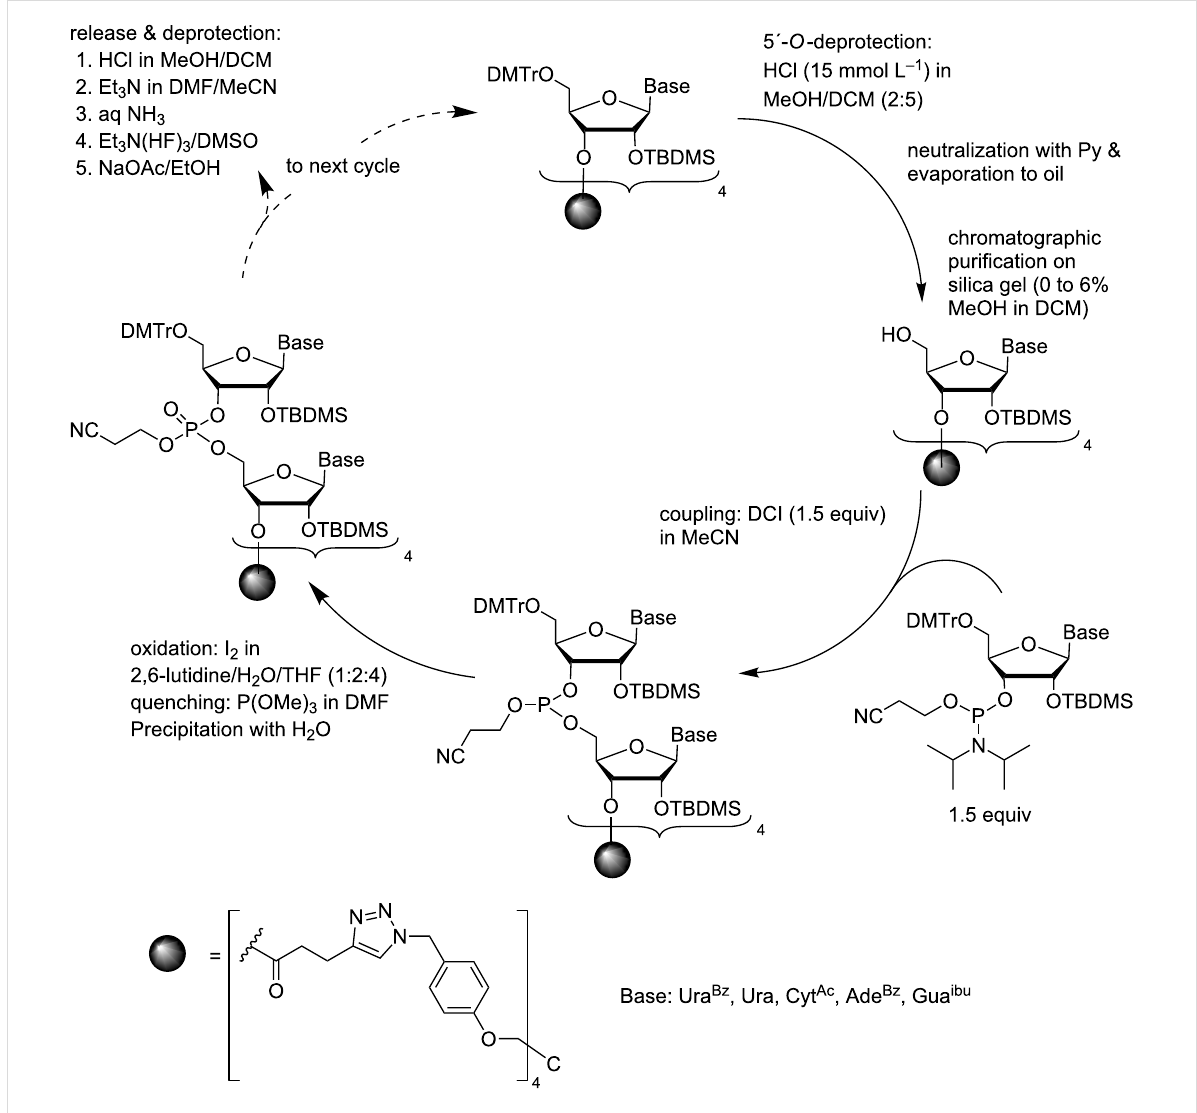
Scheme 11: Synthesis of ORNs by phosphoramidite chemistry on a precipitative tetrapodal support from commercially available building blocks